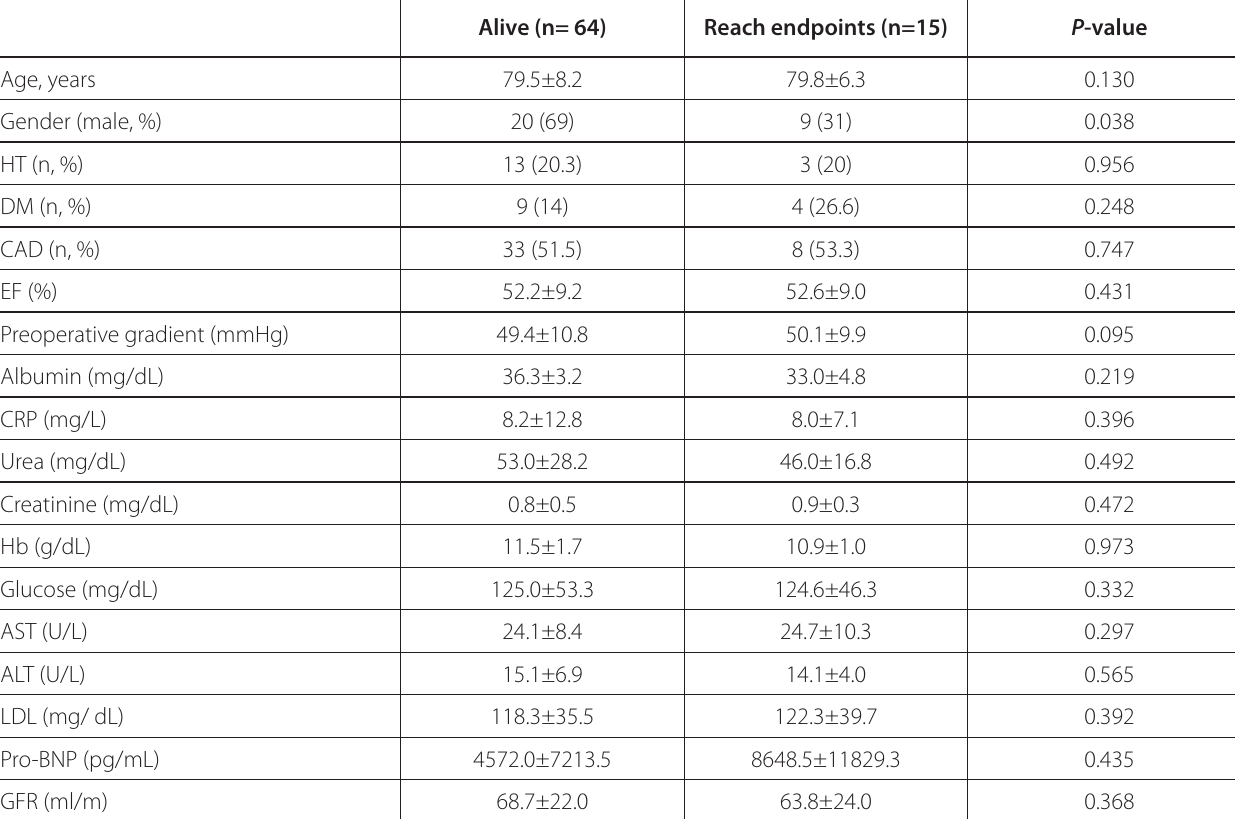
Table 2. Characteristics and echocardiographic and laboratory findings of patients according to primary